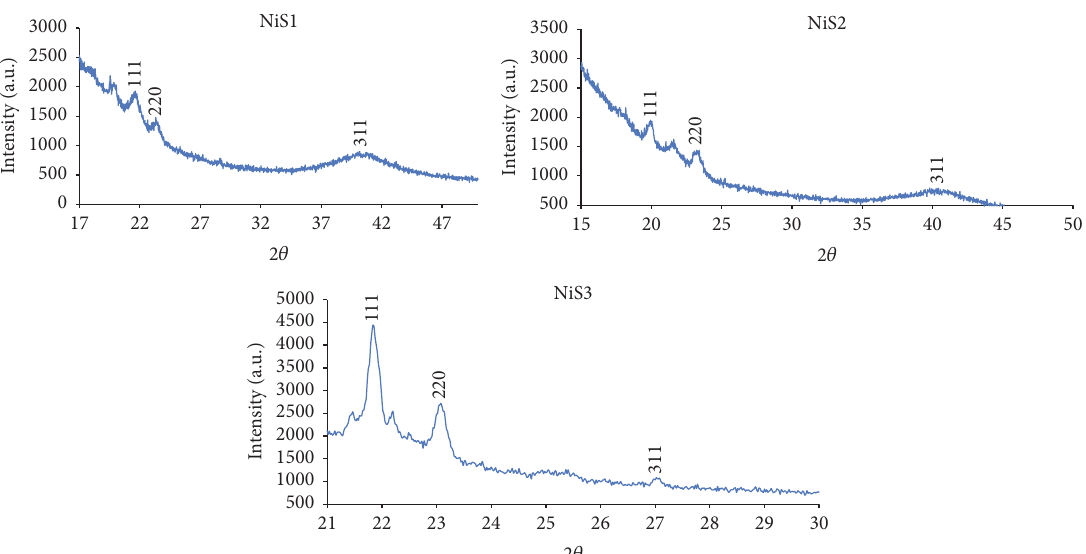
Figure 5: Powder XRD patterns of HDA-capped NiS nanoparticles.